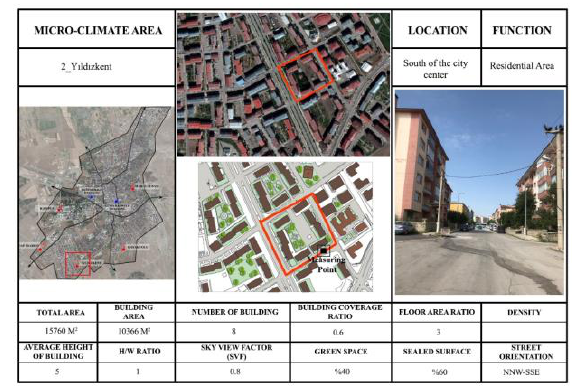
Figure 4. Spatial Analysis of Yildizkent